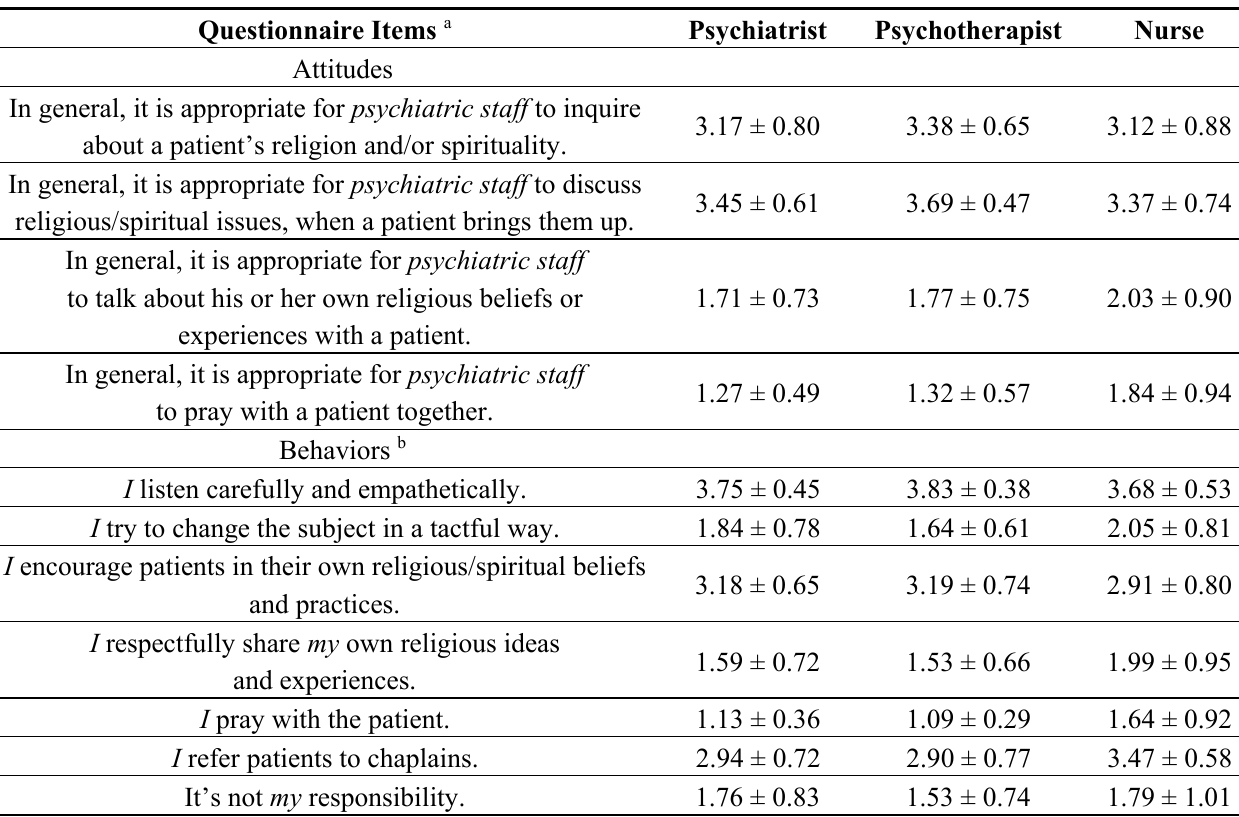
Table 4. Psychiatric staff’s self-reported attitudes and behaviors regarding religiosity/spirituality. Questionnaire Items a Psychiatrist Psychotherapist Nurse